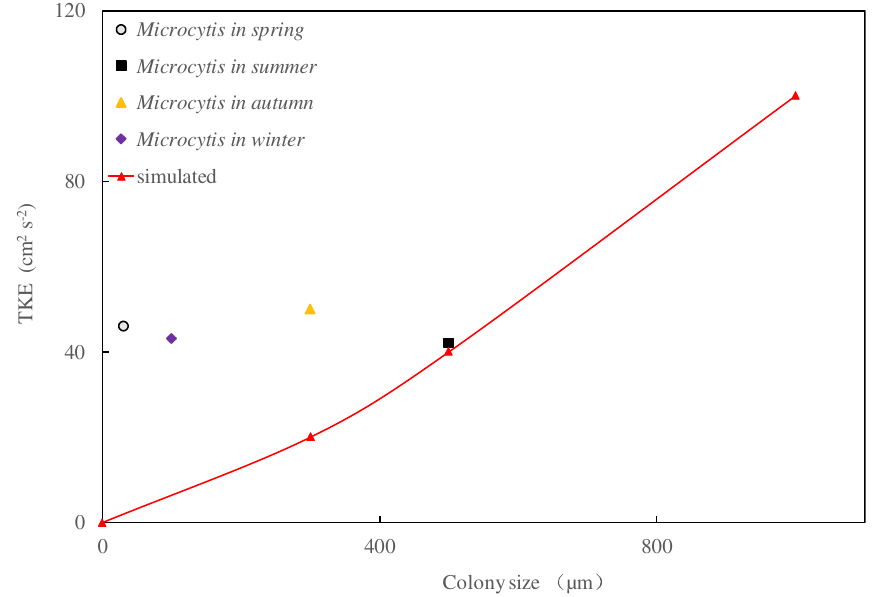
Figure 8. Relationship between colony sizes and equilibrium